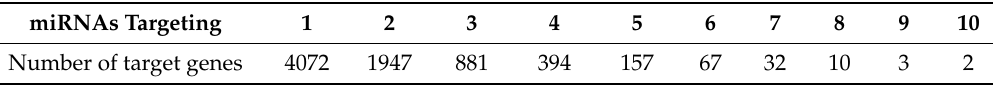
Table 2. Table showing the number of predicted target genes found to be targeted by individual miRNAs or by multiple miRNAs.